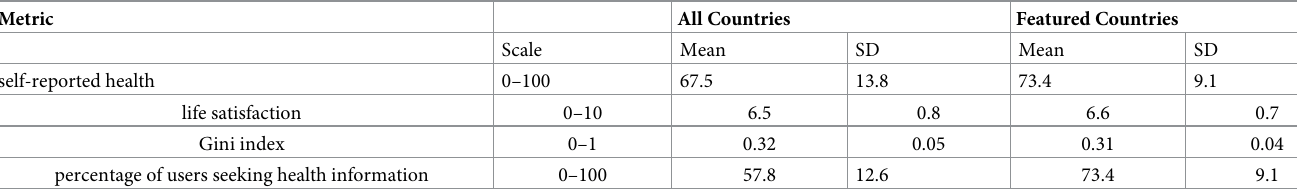
Table 1. Summary of quality of life metrics across all countries and those featured in the